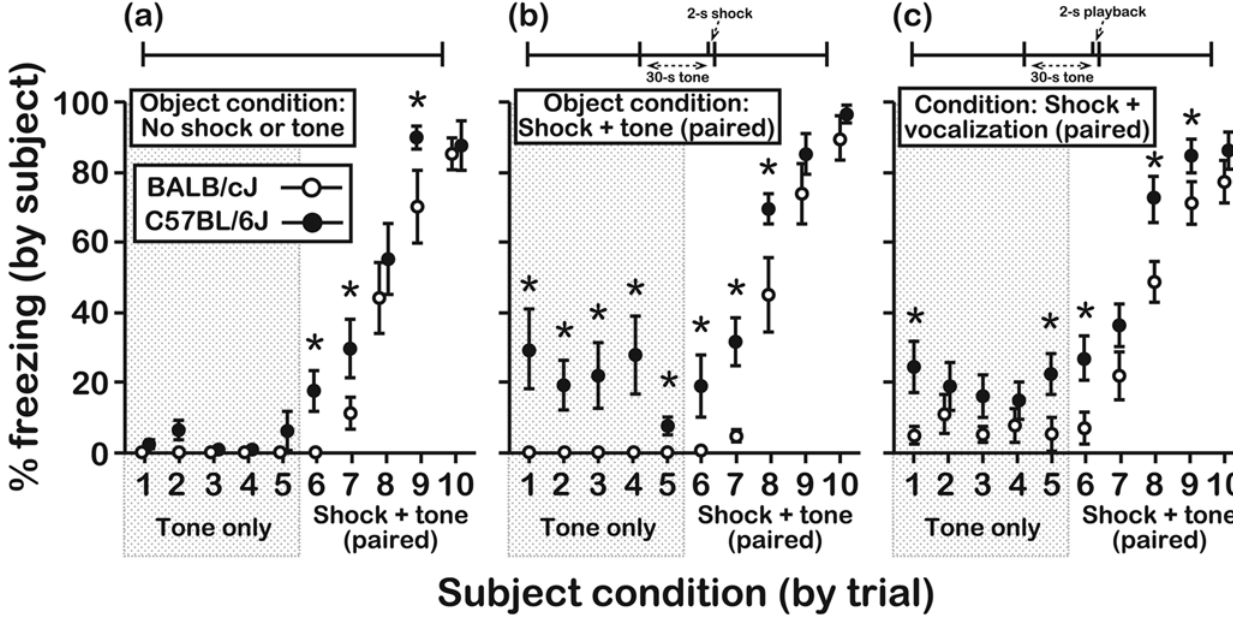
Figure 6. Freezing responses of subjects after pre-exposure to the CS paired with playback of object distress vocalizations. (a) Subjects were exposed to objects during conditioning, but the CS-UCS was not presented to objects (N=10 subjects/genotype; age=5–7 wks). (b) Subjects were exposed to objects receiving the paired CS-UCS during conditioning (N=8 subjects/genotype; age=5–6 wks). (c) Subjects were not exposed to objects, but received the CS forward paired with the playback of object distress vocalizations during conditioning (N=16 subjects/ genotype; age=5–7 wks). Asterisks represent a significant (P , 0.05) difference between subjects from the BALB and B6 strains. All data were scored in duplicate by 2 independent raters and are presented as the mean 6 s.e.m. Inter-rater reliability, r p =0.96, d.f.=659. doi:10.1371/journal.pone.0004387.g006 PLoS ONE |